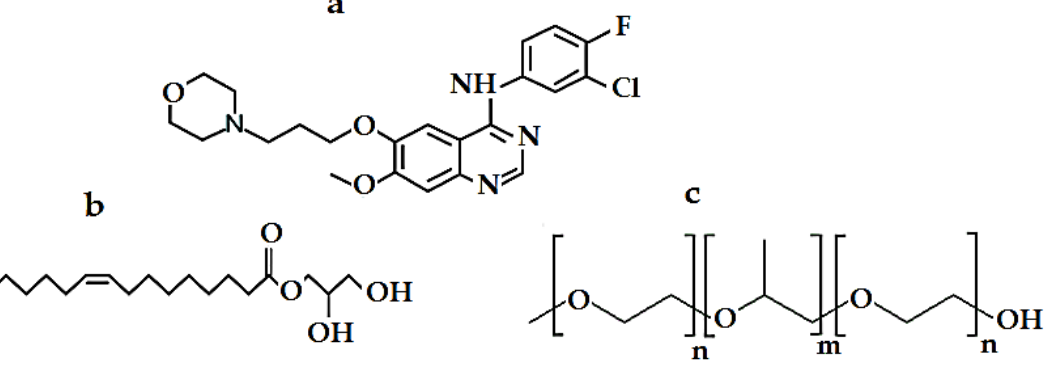
Figure 1. Chemical structure of ( a ) Gefitinib, ( b ) Glyceryl monooleate, and ( c ) Poloxamer 407. Cubosomes are considered a potential carrier in vaccine and drug delivery. Cubo‑ somes are biocompatible, bioadhesive nano‑structured cubic systems obtained by colloid dispersion of a cubic liquid crystalline structure in water using a suitable surfactant